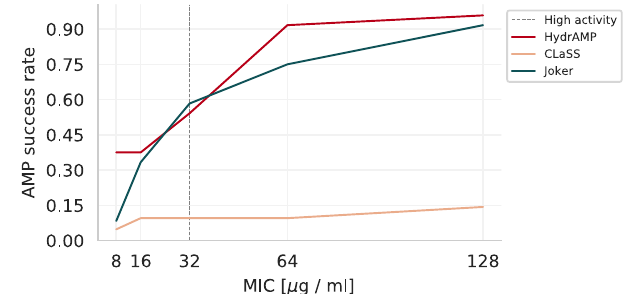
Fig. 7 | AMP success rates depending on activity threshold. AMP success rate (y-axis) for different MIC thresholds (MIC measured in units [ μ g / mL]; x-axis), for different methods: HydrAMP (red), CLaSS (beige), Joker (dark green). Source data are provided as a Source Data fi